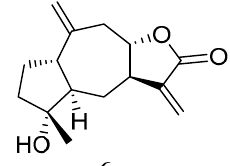
Figure 7. Structure of inuviscolide ( 6 ).